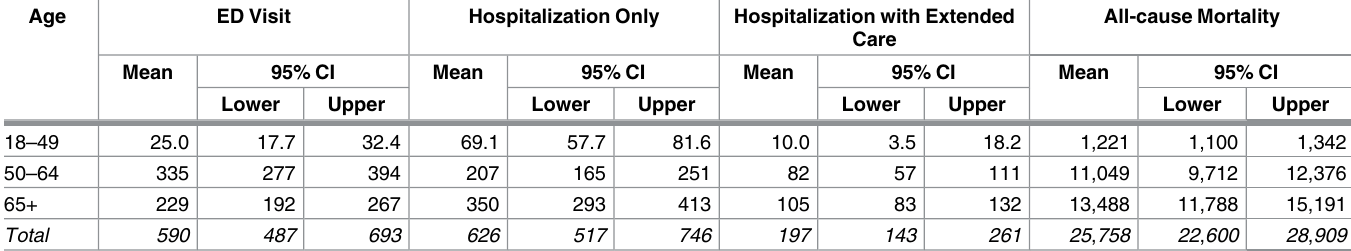
Due to rounding, numbers presented may not add up precisely to the totals provided and percentages may not precisely reflect the absolute figures.